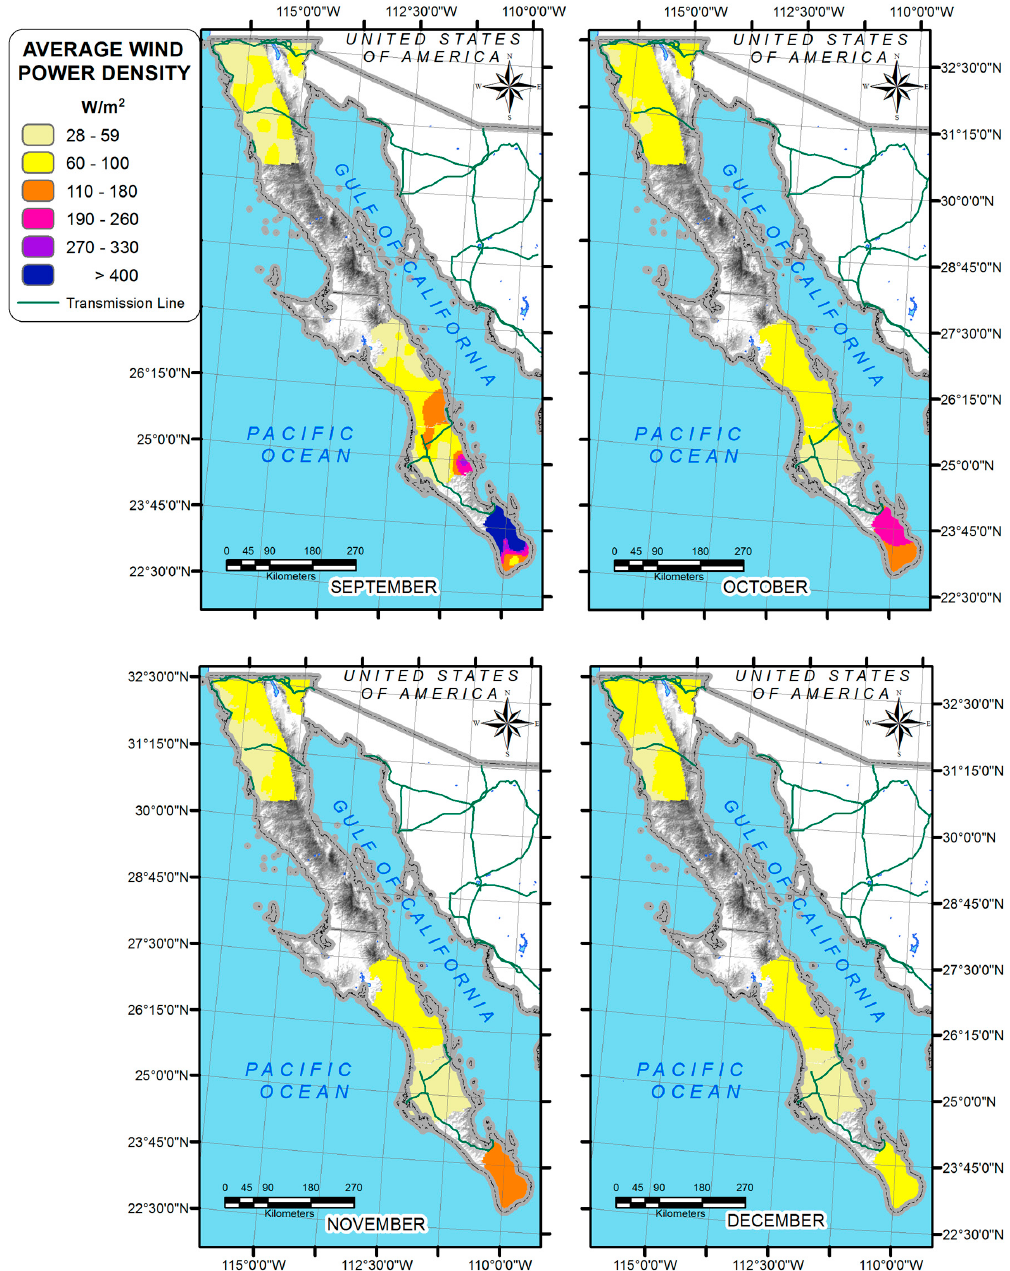
Figure 14. Average WPD from September to December.